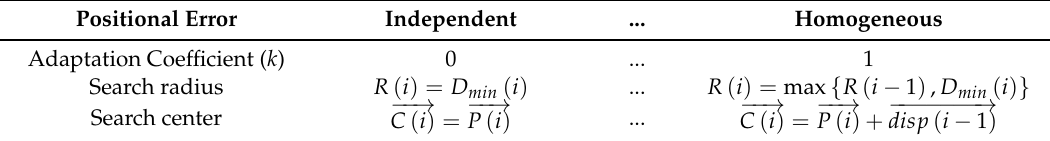
Table 2. Calculating the search radius and center for a GPS point according to the characteristic of positional error. Positional Error